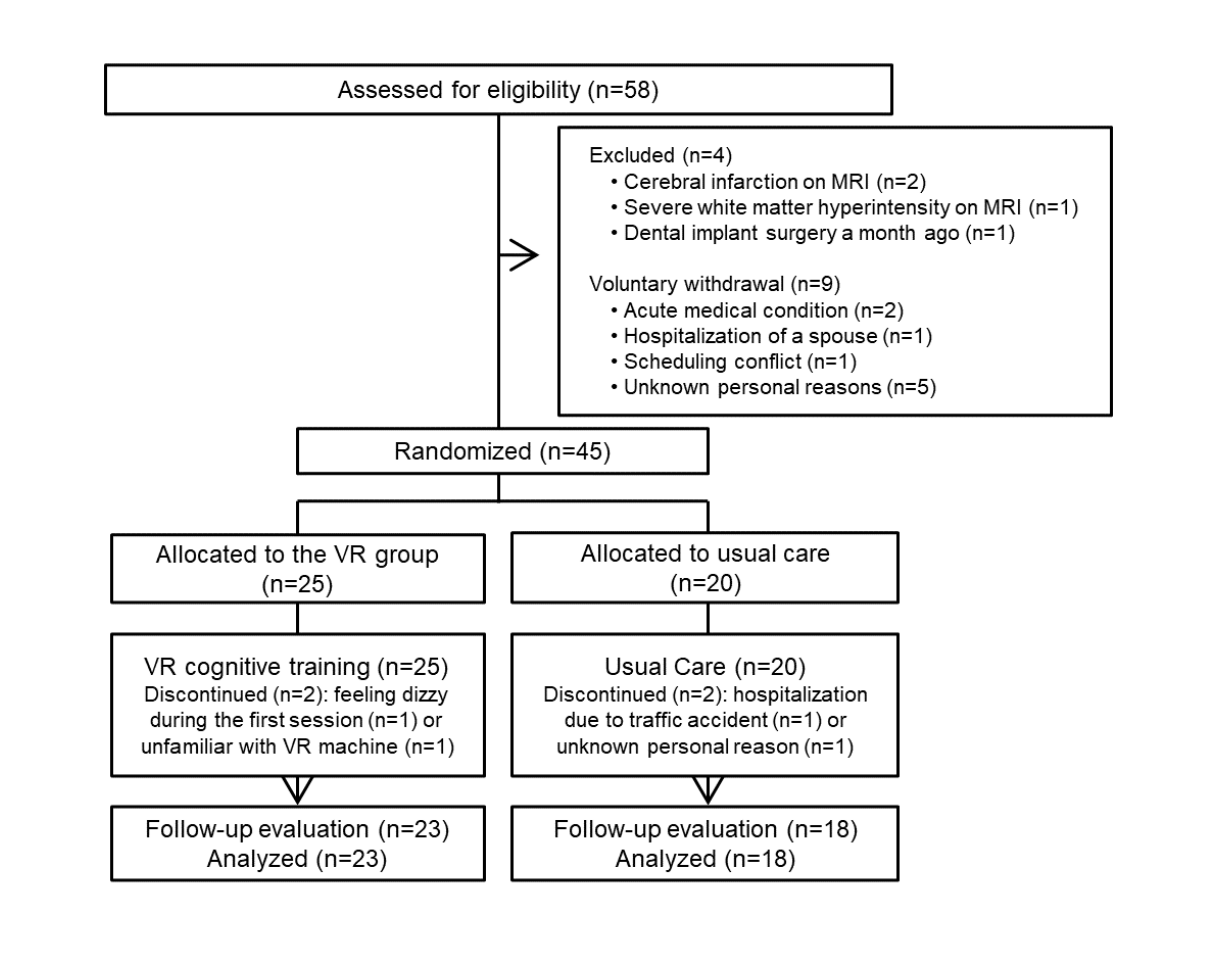
Figure 1. Trial flow chart. VR: virtual reality; MRI: magnetic resonance